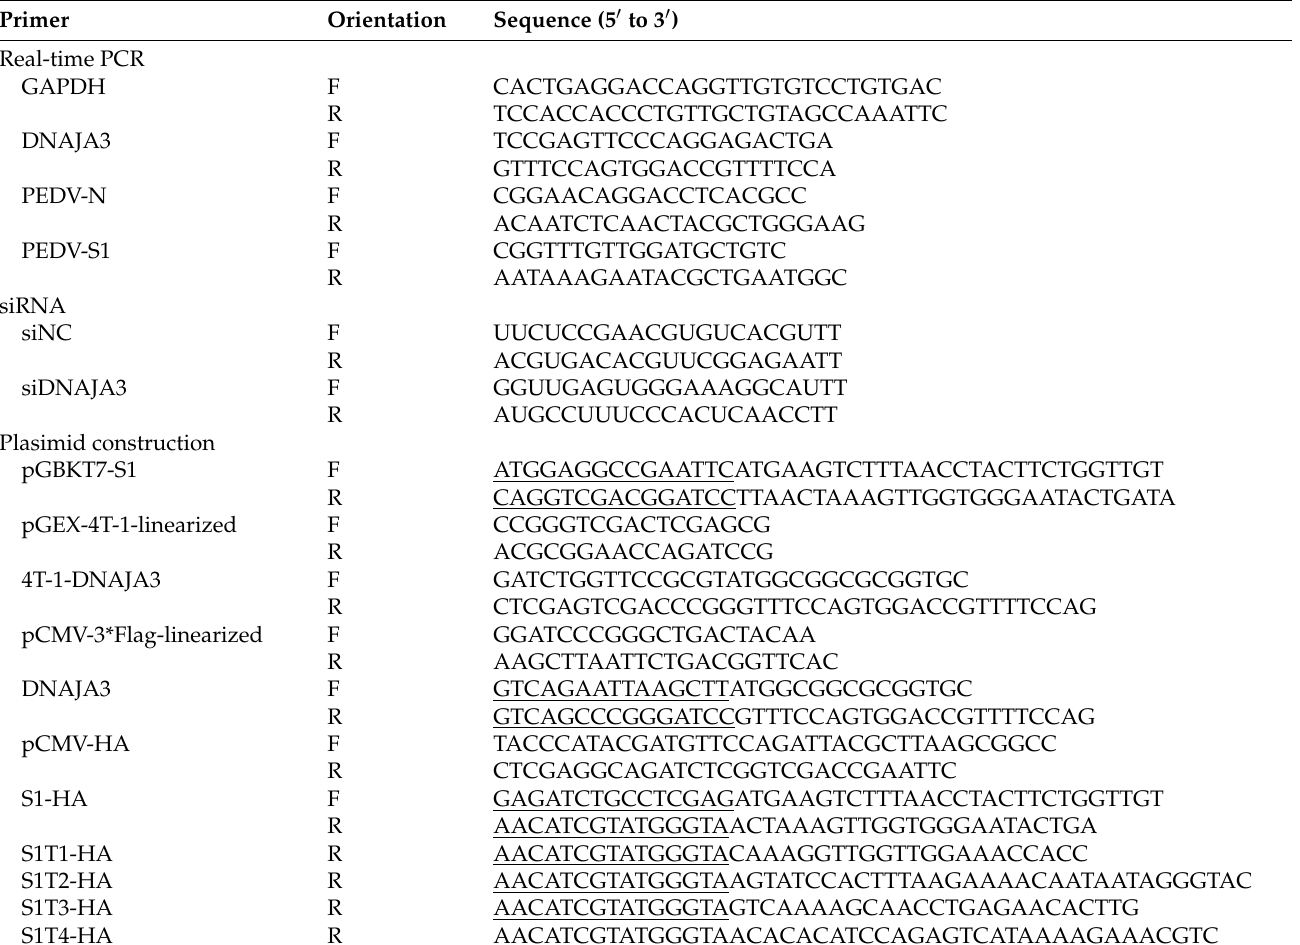
Table 1. Primers and DNAJA3 silencing sequence used in this